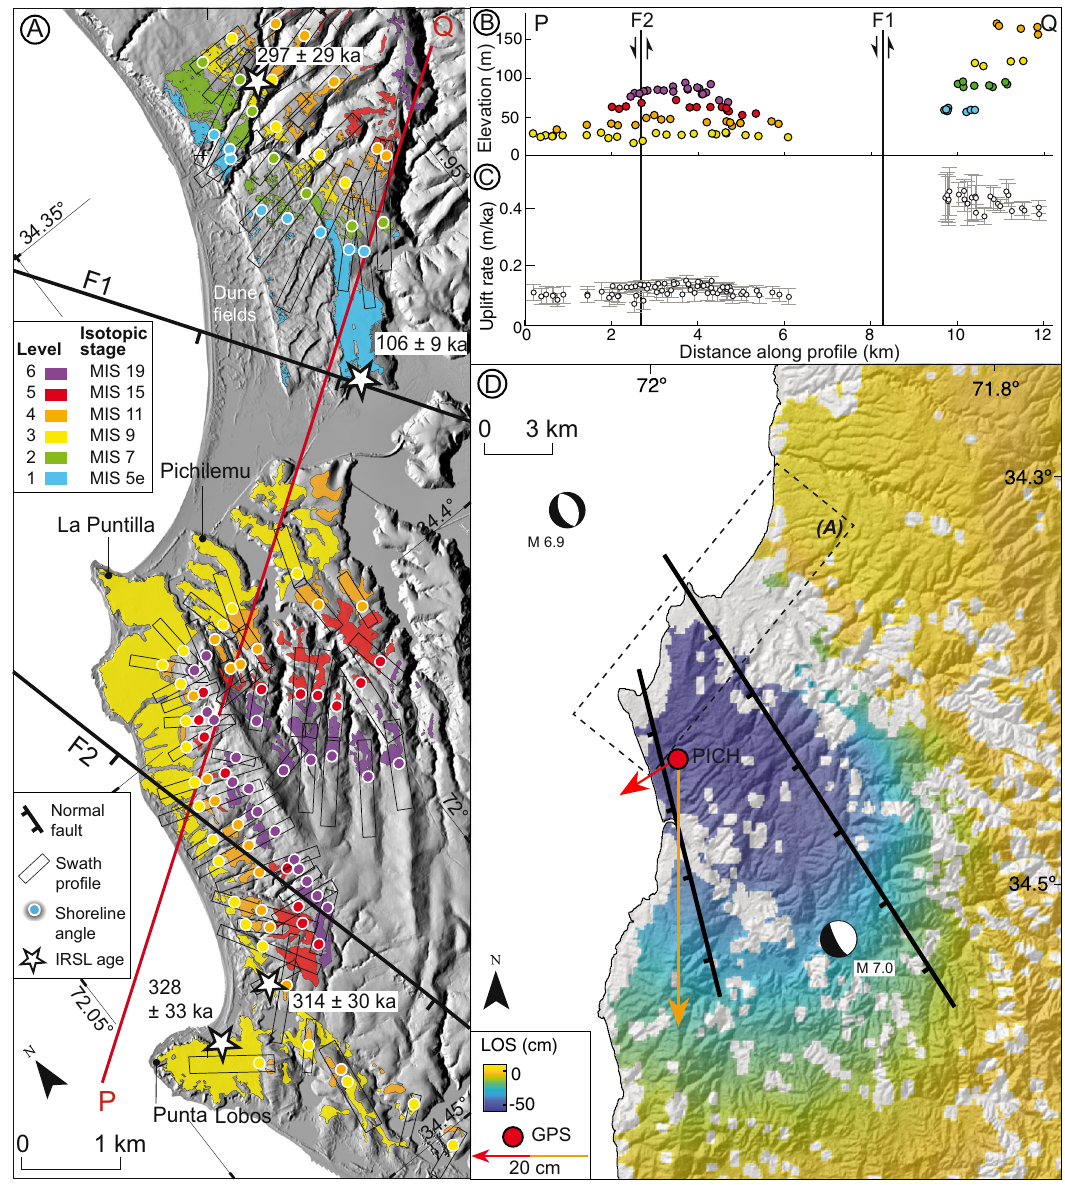
Fig. 3 Coseismic and long-term surface deformation associated with the PIF. A Map of the six levels of marine terraces in the PIF area and ages assigned to Marine Isotope Stages (MIS). Boxes show the location of swath pro fi les used to map shoreline angles (colour-coded points). Thick black lines denote the two PIF branches (F1 and F2). B Shoreline angles projected along pro fi le P – Q; arrows indicate relative displacements of F1 and F2. C Uplift rates deduced from shoreline angles along pro fi le P – Q, grey lines are standard error estimates of uplift rates (se calculation details in Methods Section Analysis of off-fault geomorphic features). D Coseismic Line-of-Sight (LOS) displacements in the Pichilemu area determined from Envisat ® radar interferometry of the 2010 PIF earthquakes. Red and orange arrows represent horizontal and vertical displacements, respectively, estimated at the continuous GPS station PICH (red dot) as a result of the 2010 PIF earthquakes 34